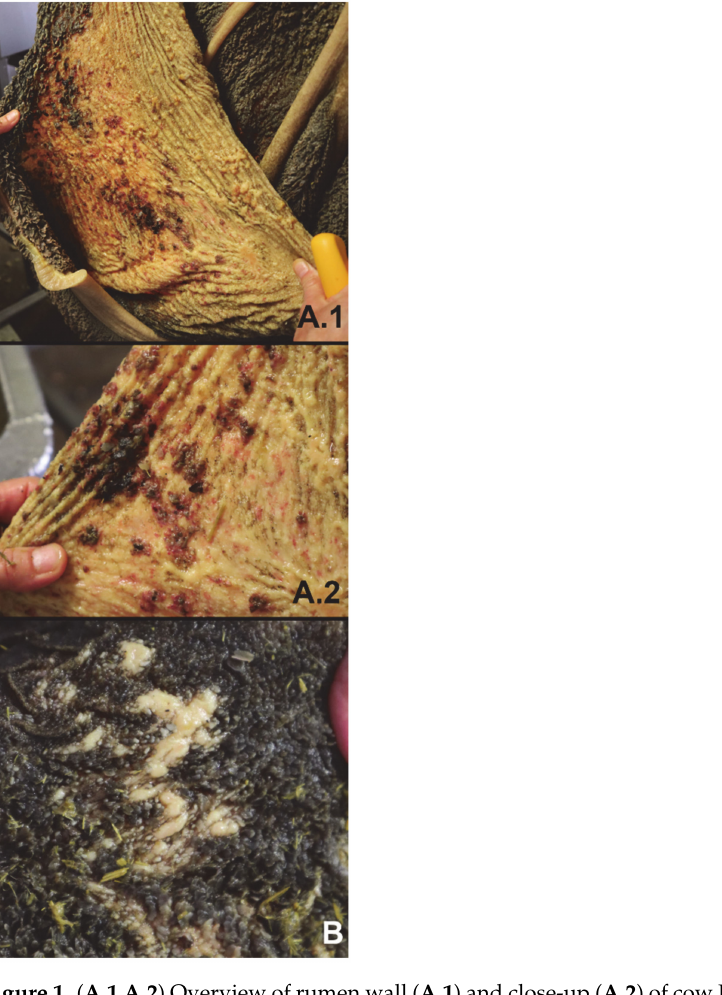
Figure 1. ( A.1 , A.2 ) Overview of rumen wall ( A.1 ) and close-up ( A.2 ) of cow L1 indicating the absence of rumen papillae on large parts of the rumen wall and presence of hemorrhages and ulcers. ( B ) Close- up of rumen wall of cow L6 with local absence of rumen papillae and thickening of the rumen wall (yellowish white